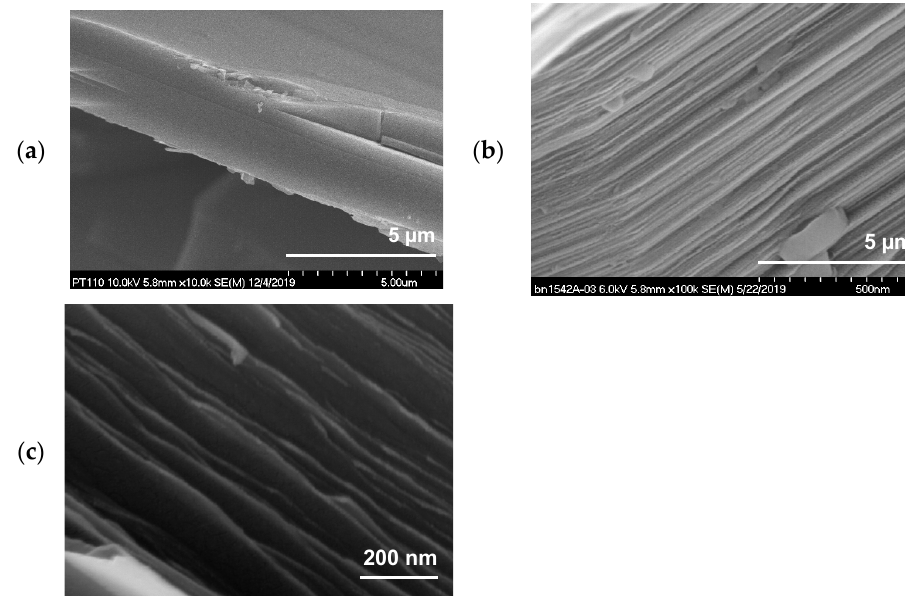
Figure 9. SEM micrographs of ( a ) commercial h-BN PT110, ( b ) h-BN PT110 intercalated with iron chloride, and ( c ) exfoliated h-BN (PT110).